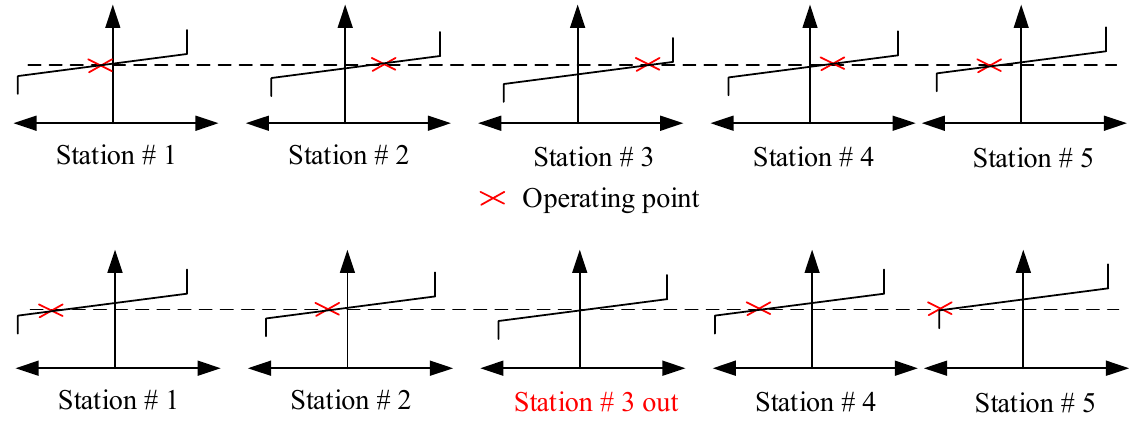
Figure 13. Characteristics of power sharing in a five-terminal MTDC system.